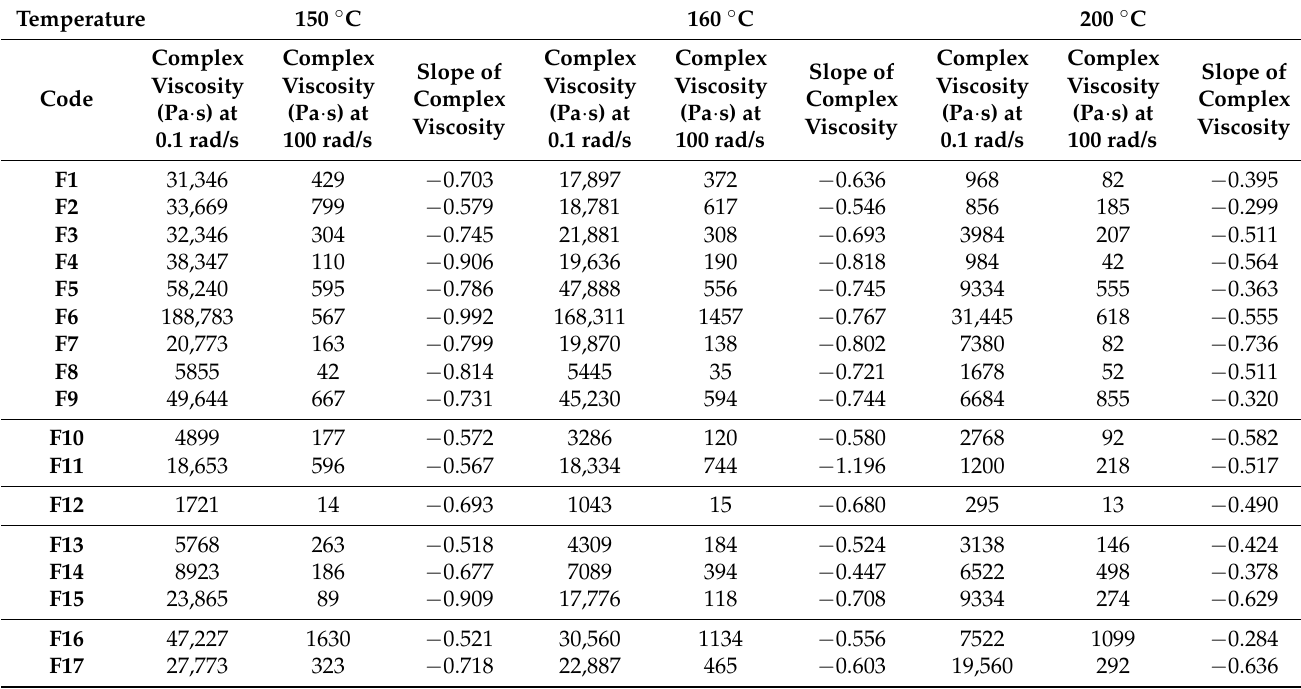
Table 2. Comparison of complex viscosity and slopes of complex viscosity vs. oscillation frequency at different temperatures for 17